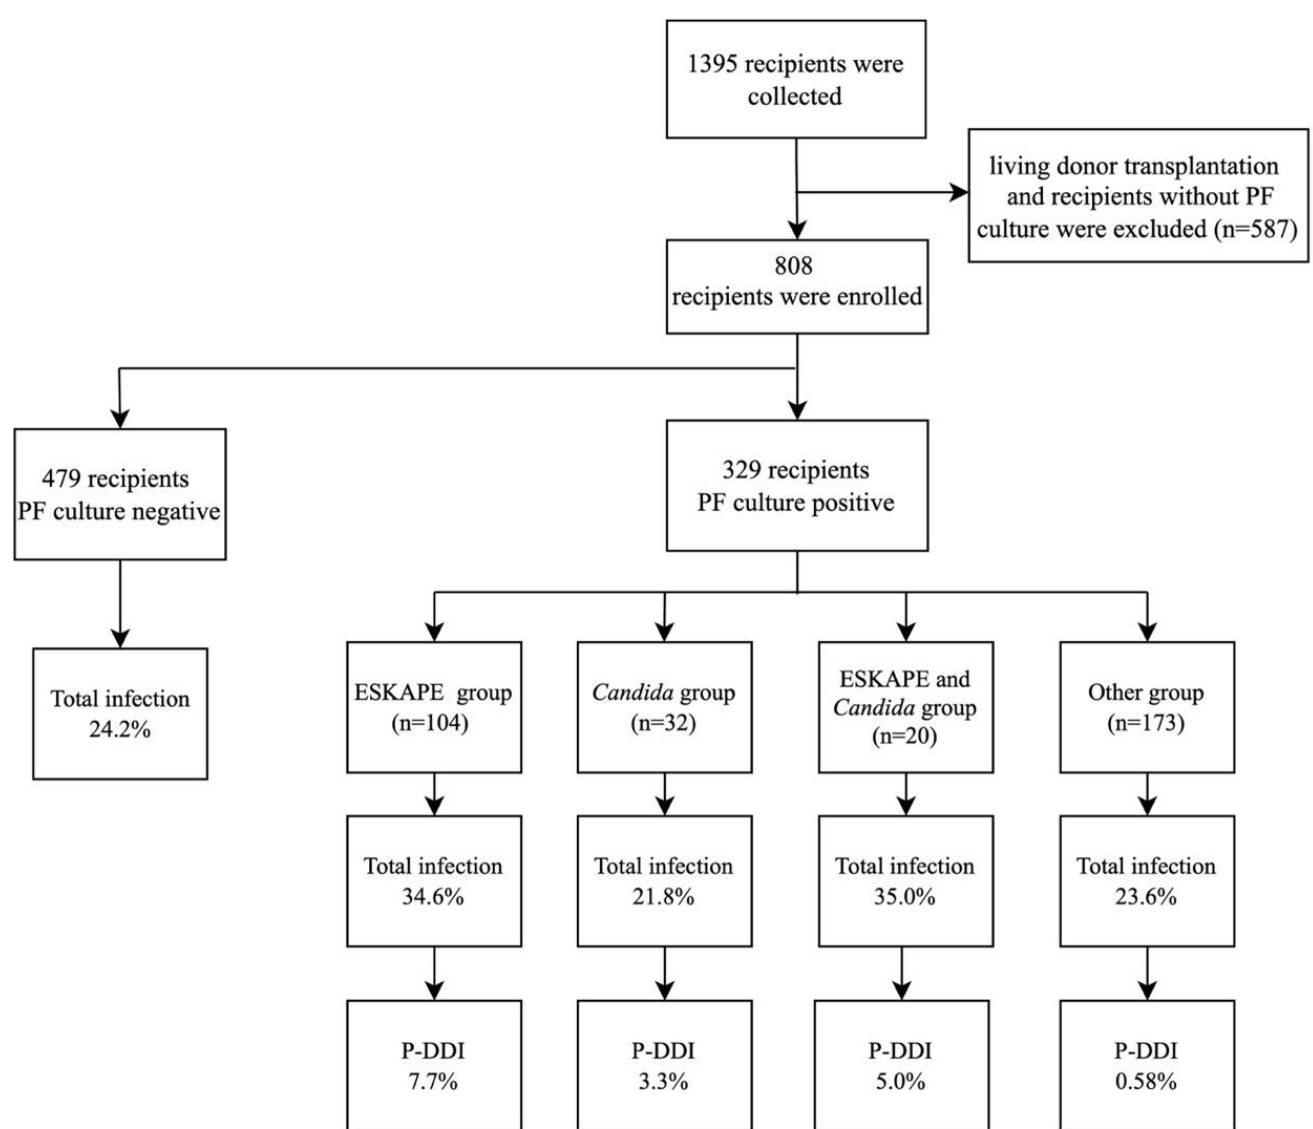
Figure 1. Cultures results in the preservation fluid (PF) and early infection-related events incidence rates. Recipients with simultaneous cultures of ESKAPE and other pathogens were classified in the ESKAPE group. Recipients with simultaneous cultures of Candida species and other pathogens were classified in the Candida group. Recipients with simultaneous cultures of ESKAPE and Candida species were classified in the ESKAPE and Candida group. Table 1. Donor and recipient characteristics.